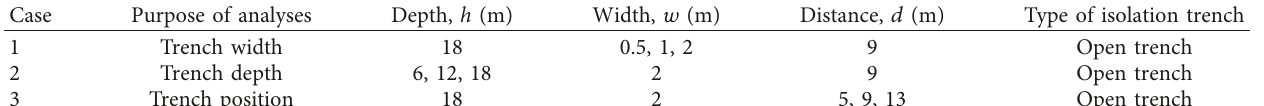
Table 5: Numerical simulation cases.